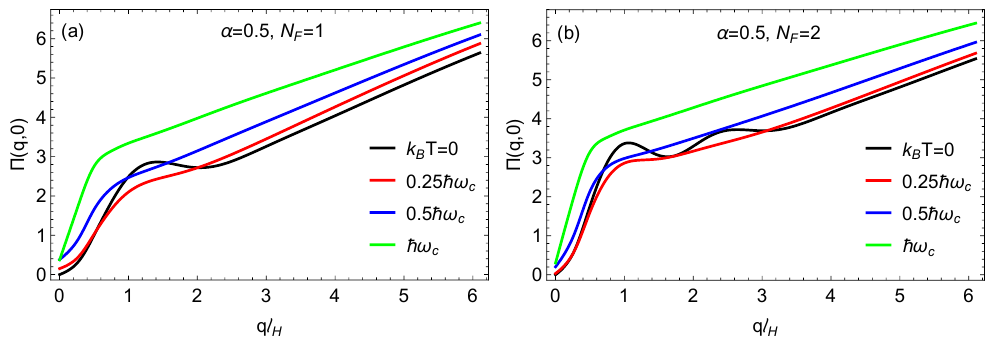
Figure 7. Plots for the static polarization for various temperatures and two values for ( a ) N F = 1 and ( b ) N F = 2, which refers to the index of the highest occupied Landau level at T = 0 K. The magnetic length is denoted by l H and the cyclotron frequency by ω c